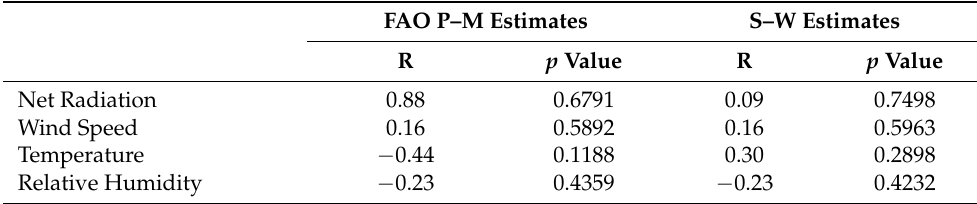
Figure 3. Sensitivity of the FAO P–M model to net radiation, wind speed, temperature and relative humidity. relative humidity. Table 2. Pearson correlation coefficient (R) between PET estimates (from FAO P–M and S–W models) and models’ meteorological parameters, and p